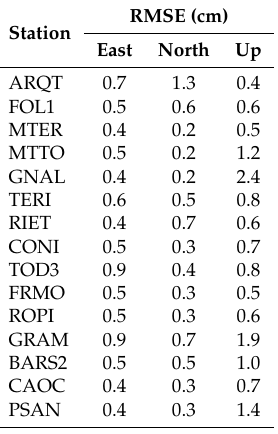
Table 4. Comparison between A-VADASE-LOO and PPP solutions: 30 October 2016 earthquake.